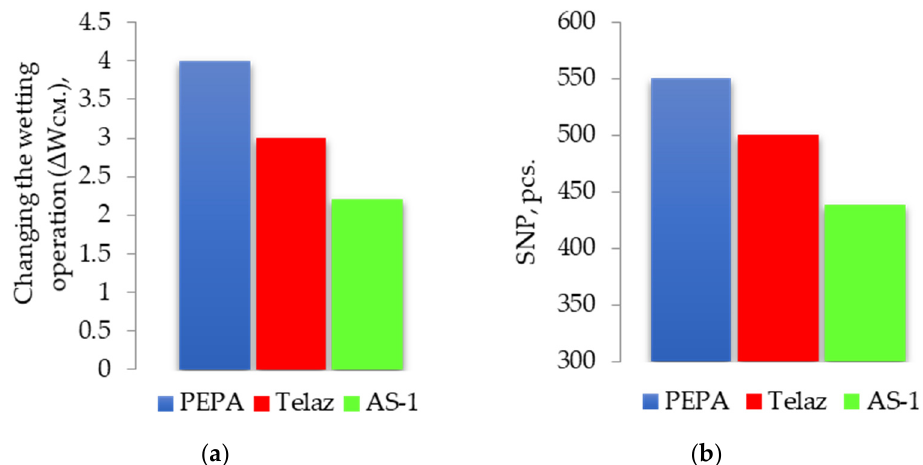
Figure 7. The effect of additives on the change in the wetting operation ( Δ W cm ) with respect to ( a ) the aluminum substrate (SC 10%) and ( b ) the dispersion of the pigment (SNP, pcs.) at CS 0.25 g/dm 3 and a temperature of 25 °C [30].